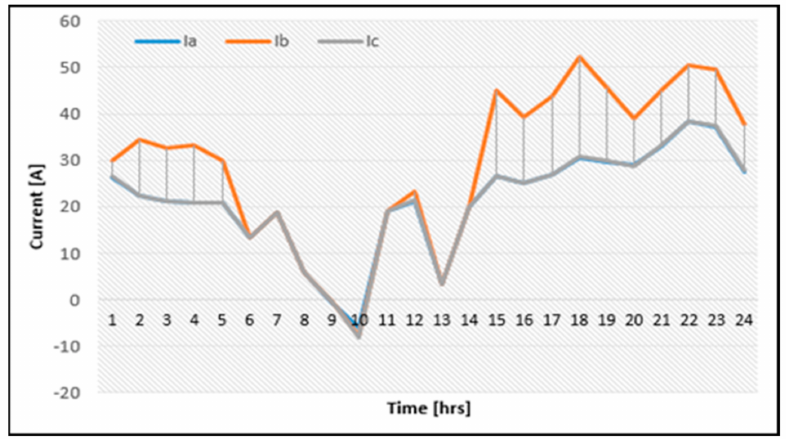
Figure 19. The aggregated phase currents at the level of the CCP obtained with the proposed methodology, P-PLB case.